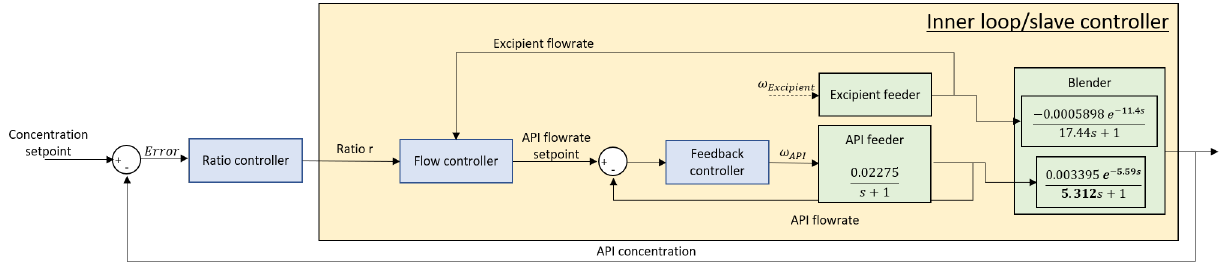
Figure 6. A ratio control structure solution for the blender